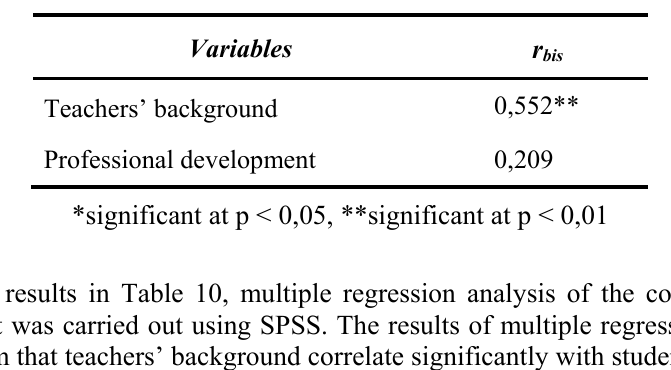
Table 10 : Correlation between students’ achievement